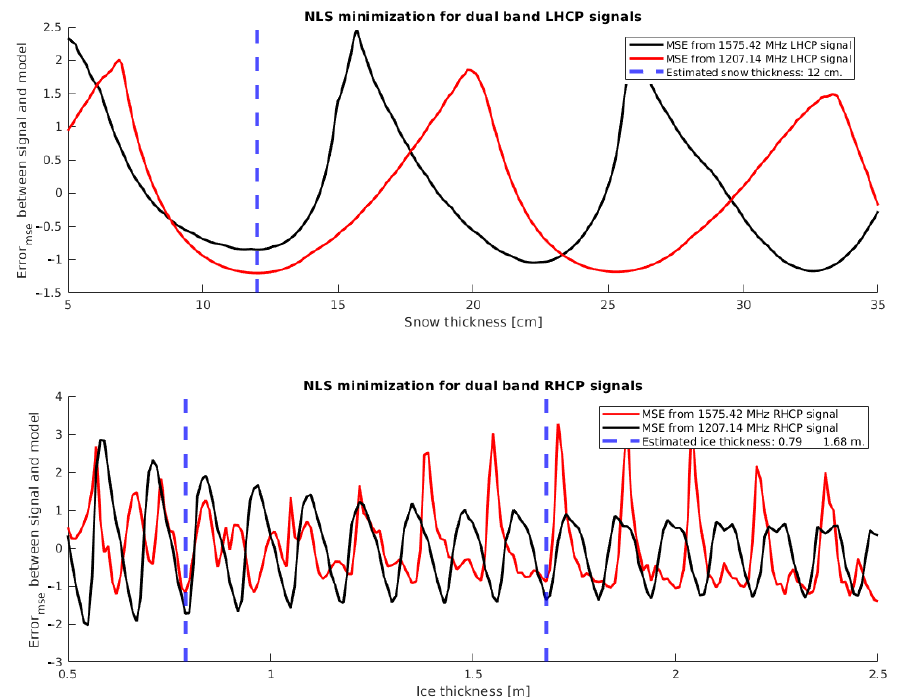
Figure 14. NLS minimization output for the data set between the 23rd and the 27th of December, 2019. MSE is represented for both snow and ice thickness, for different frequencies and signal polarization, and it has been normalized (z-score normalization) to ease its visualization. Note that the blue-dashed line shows the exact thickness at which both signals present a minimum.